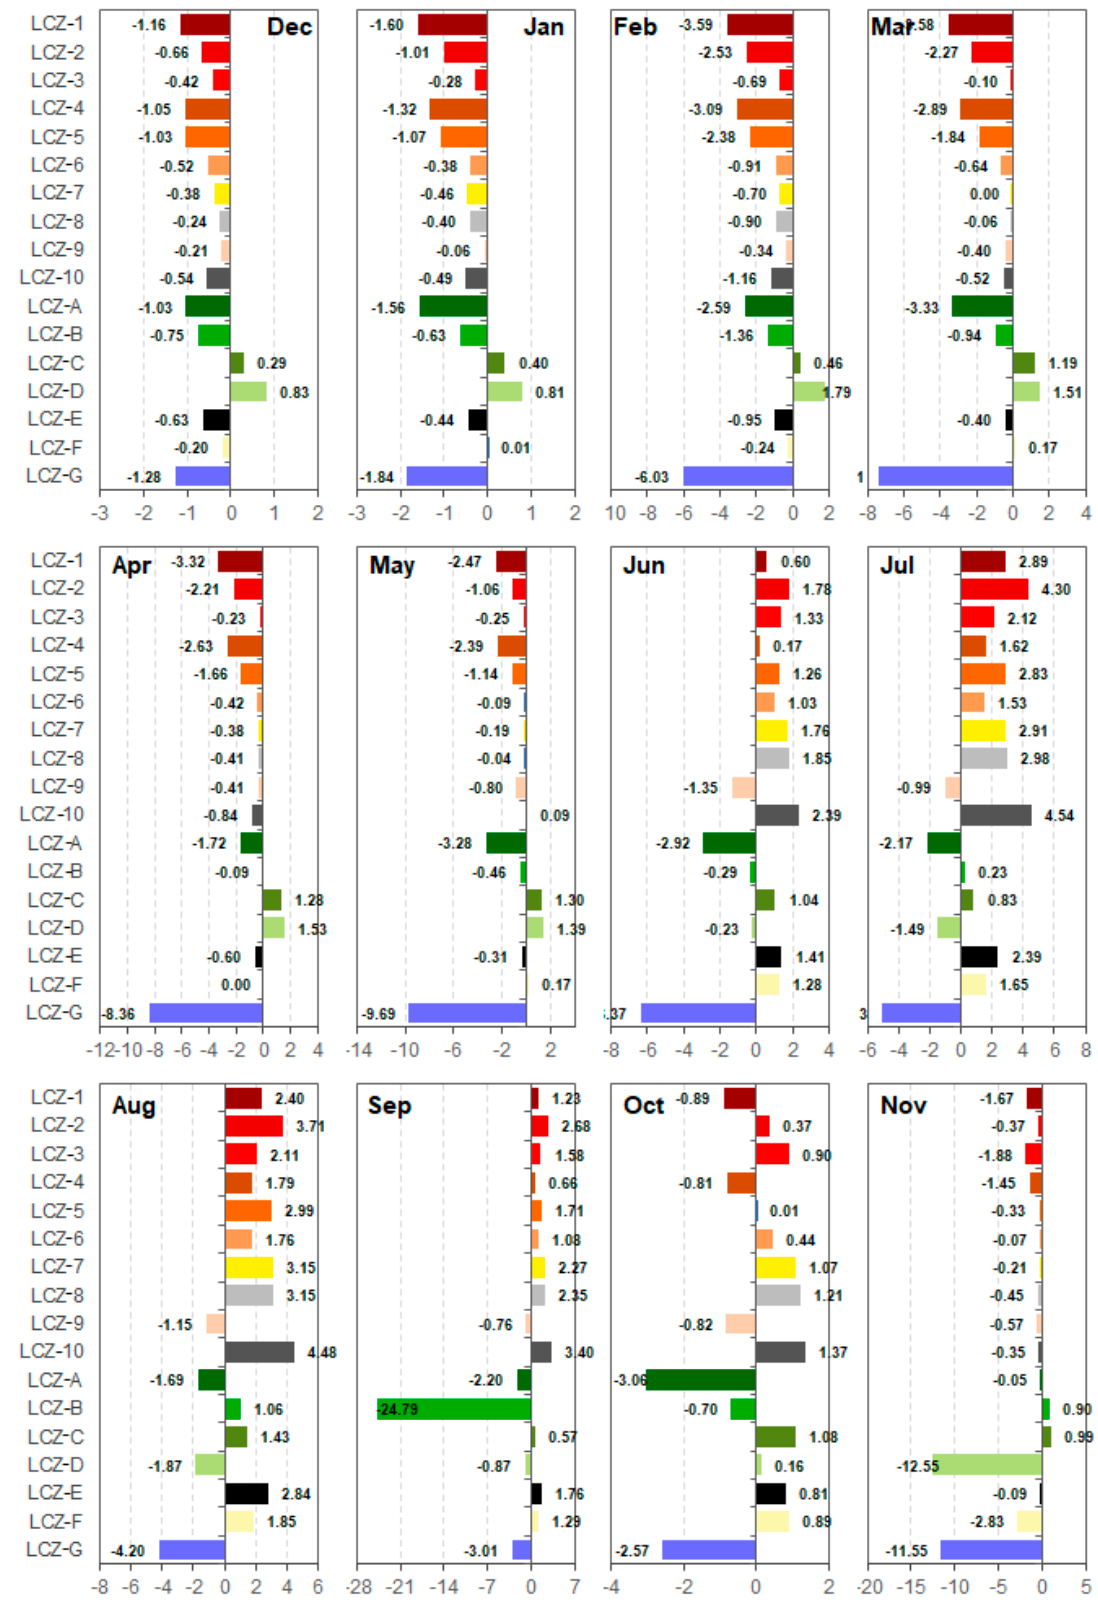
Figure 6. Deviation of the LST of different types of LCZs from the average LST of whole study area from 2018 to 2020 (°C).